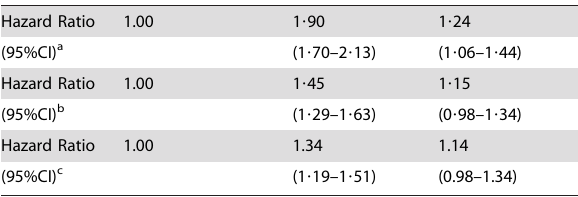
Table 2. Association between Ethnicity and All-Cause Mortality Following Diagnosis with Breast Cancer in 5,264 Southeast Asian